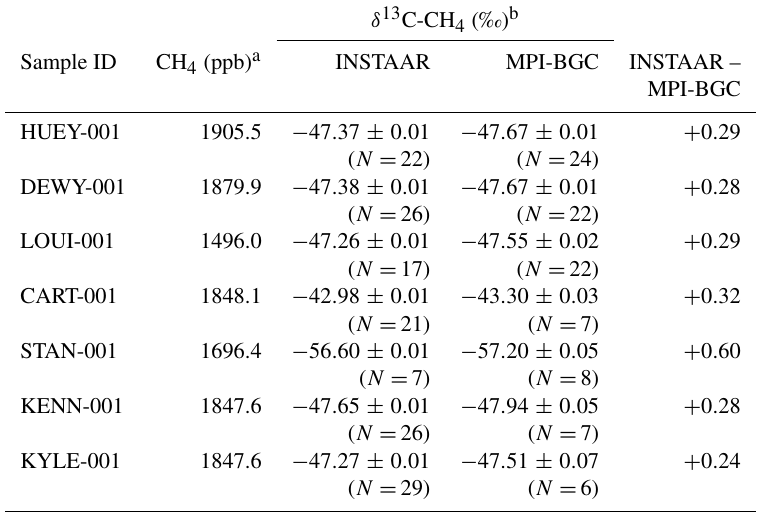
Table 6. Results of a δ 13 C-CH 4 intercomparison between INSTAAR and